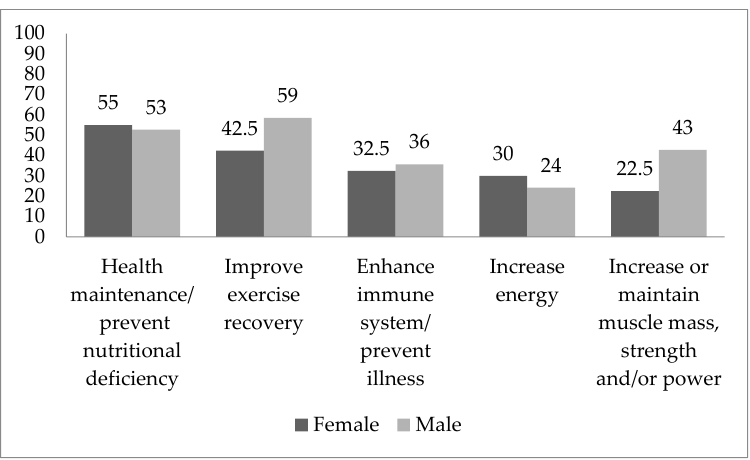
Figure 1. Comparison of rationale for taking dietary supplements in female and male group, pre- sented as proportion of each cohort (%).